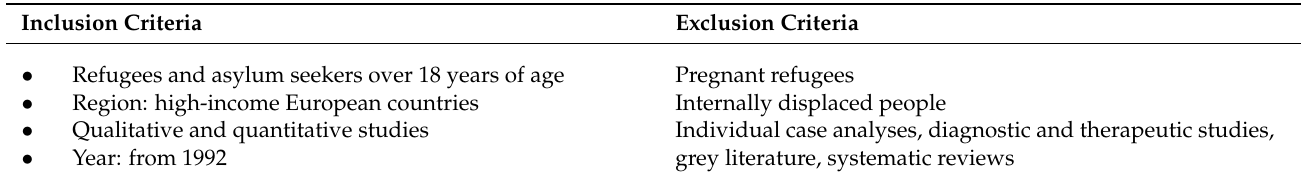
Table 1. Inclusion and exclusion criteria for the literature search.